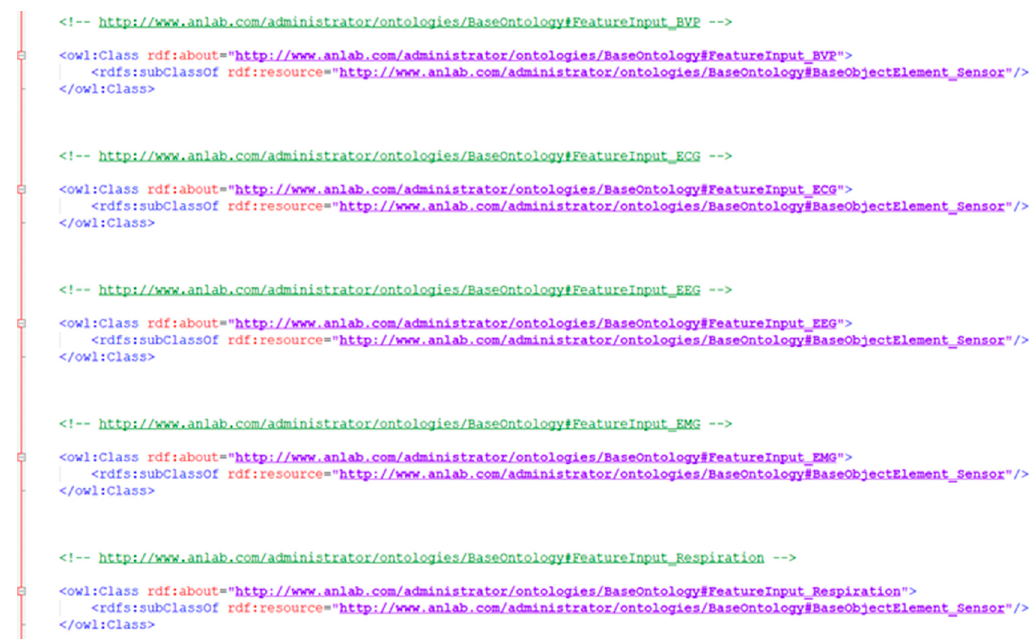
Figure 17. Base ontology feature inputs to express data from multiple ontologies.